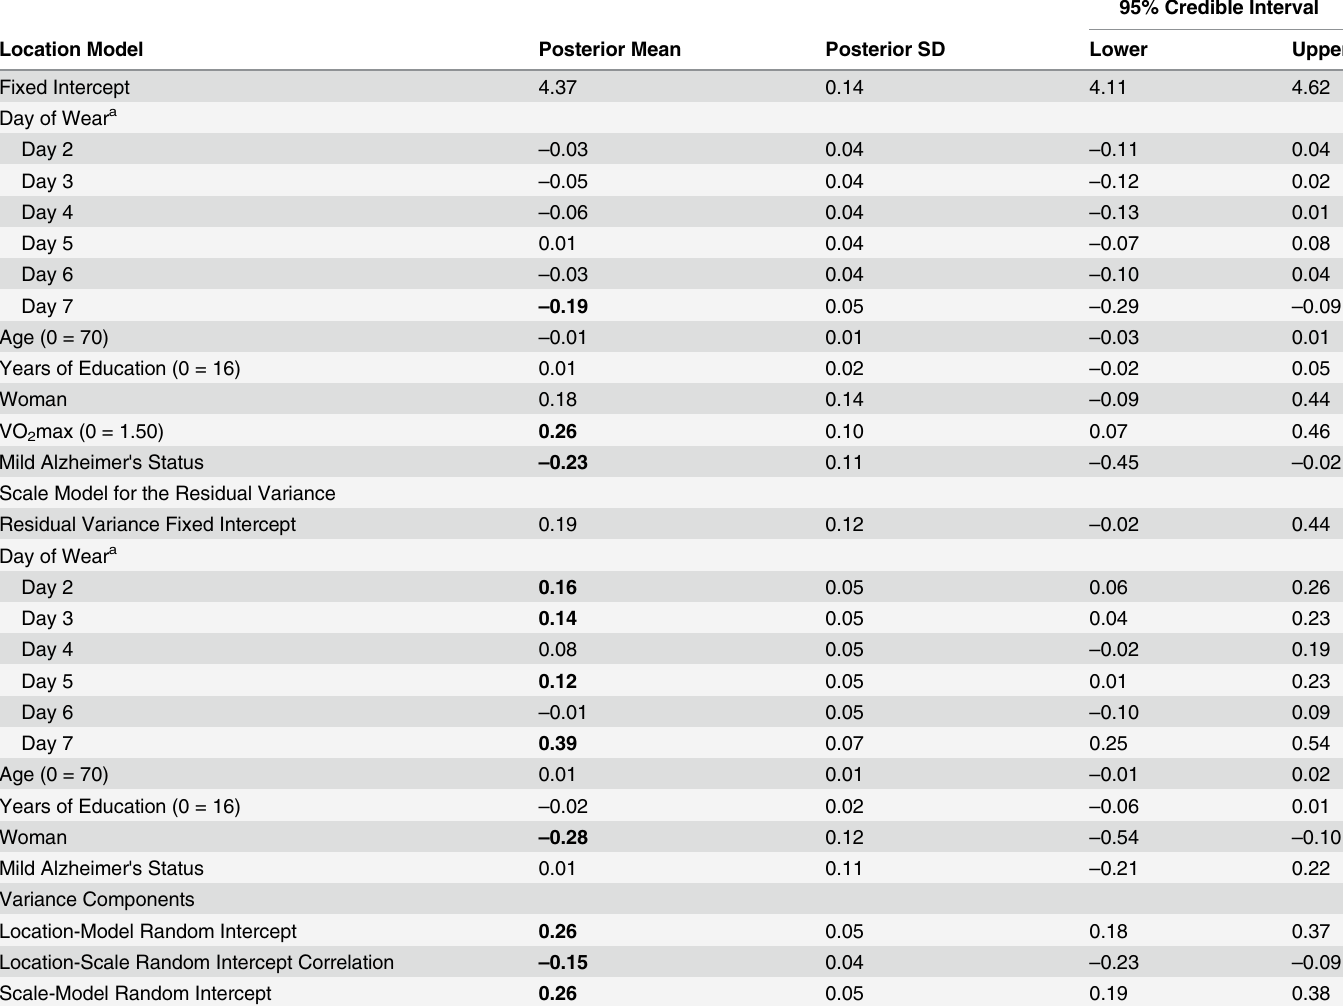
Table 2. Results of the Final Mixed-Effects Location-Scale